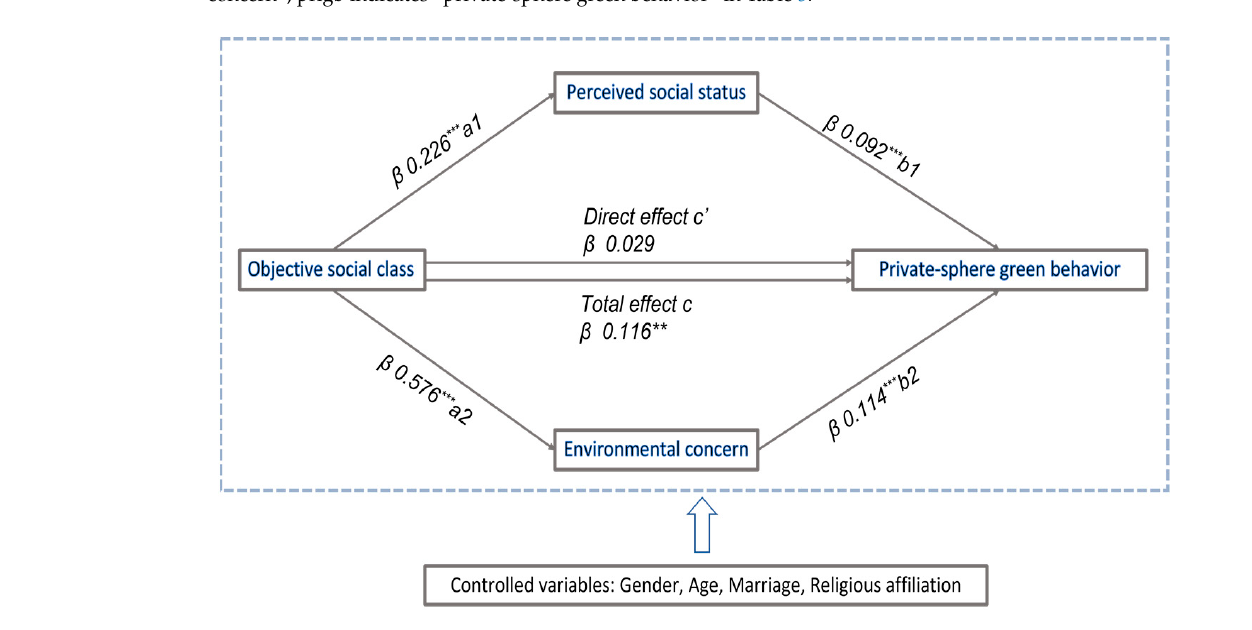
Figure 2. Path model diagram with the results of parallel mediation analysis. Notes: * p < 0.1, ** p < 0.05, *** p < 0.01.